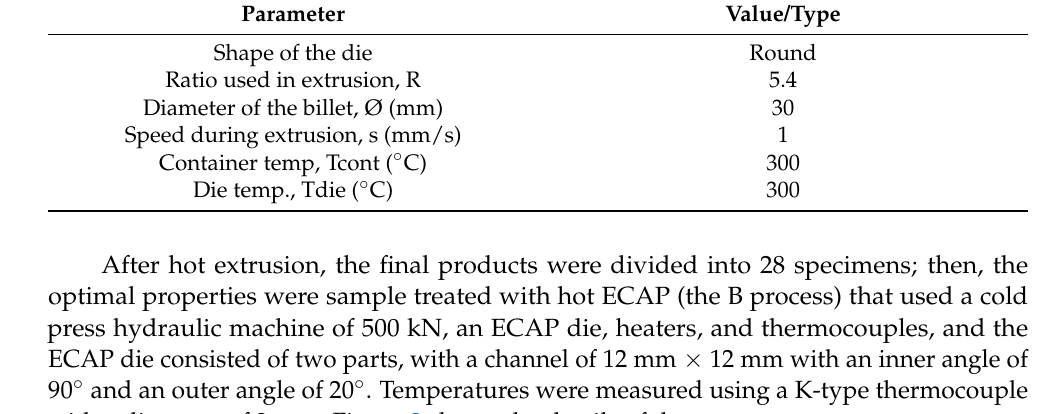
was used as the quenching medium.